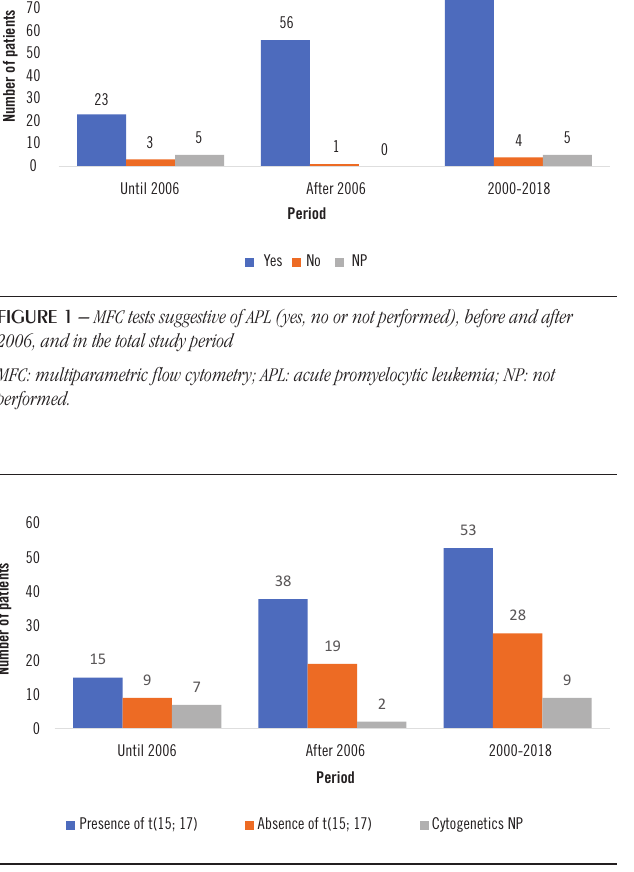
Figure 2: Conventional cytogenetics patients with translocation (15; 17) present, absent or figurE 2 – Conventional cytogenetics of patients with translocation t(15; 17) present, unrecognized before and after 2006, and in the total period of study. ND: Not absent or unrecognized before and after 2006, and in the total study period NP: not performed.